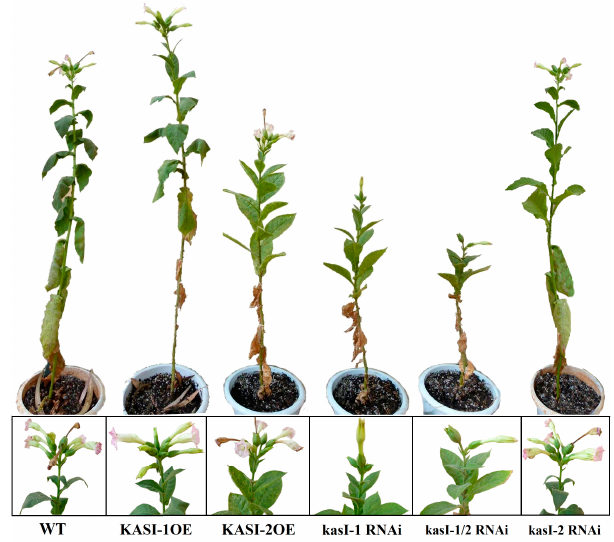
Figure 8. Phenotype of reproductive growth.